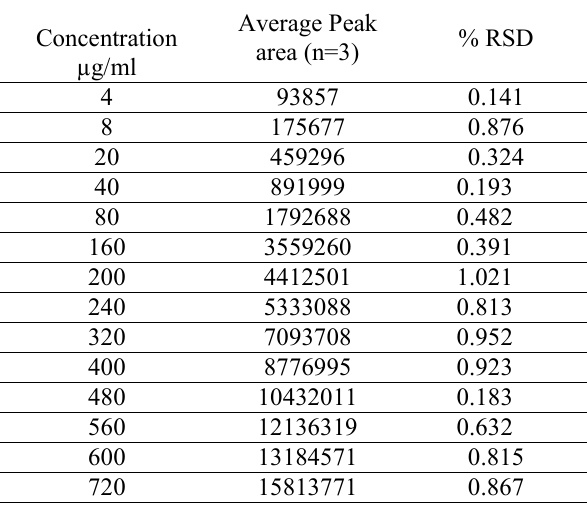
Table 1 . Calibration data of